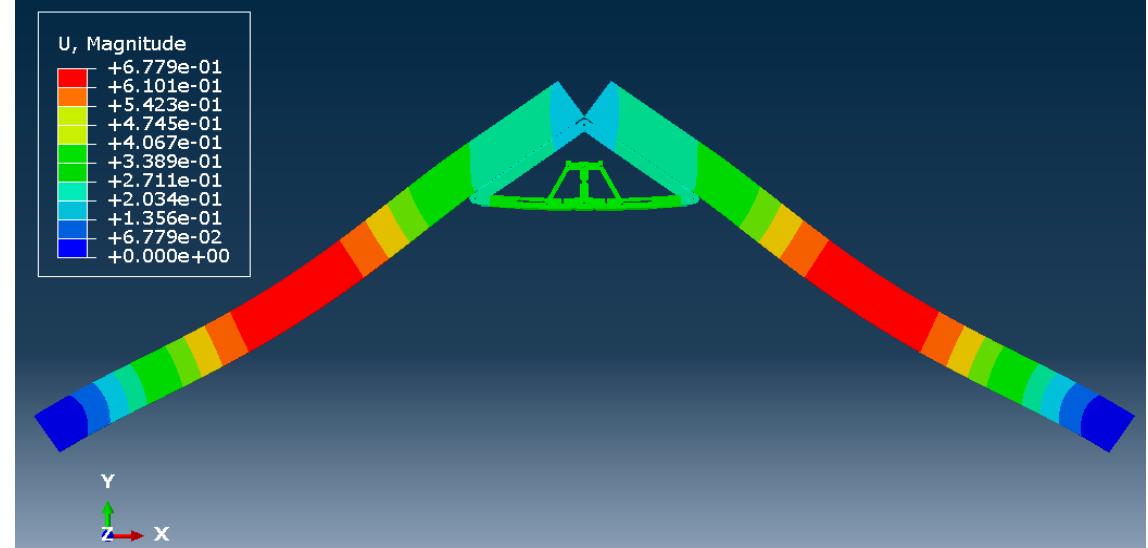
Figure 26. The deflected shape of the structure for a factored gravity load of 4 kPa.